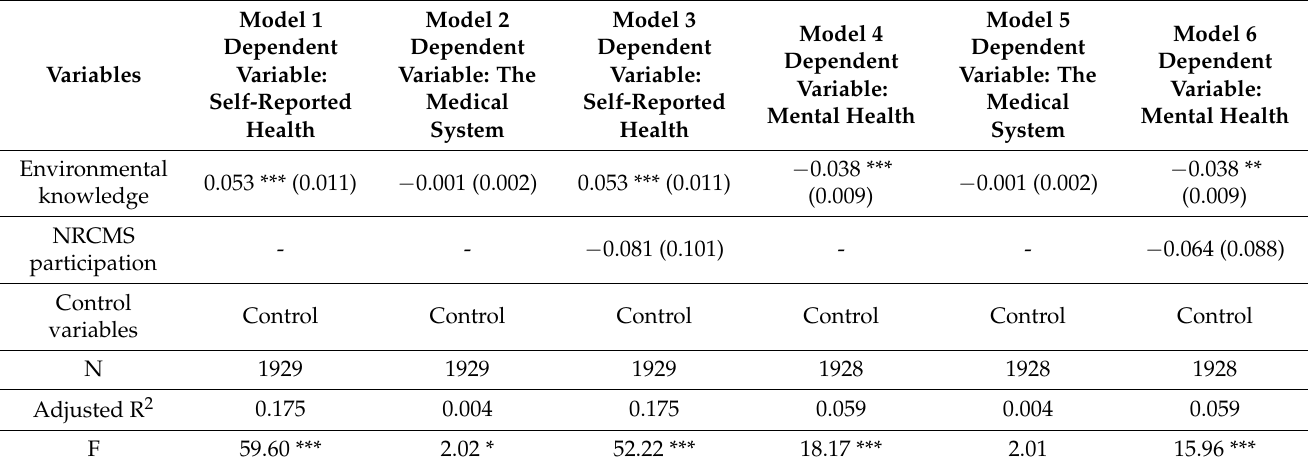
Table 6. Mediation test of the medical system on EK and women’s physical and mental